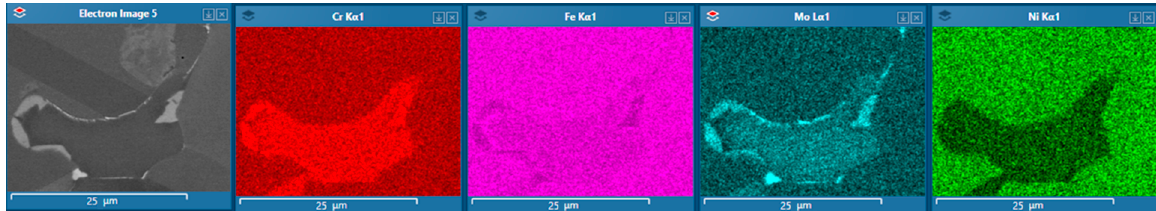
Figure 12. ThermoCalc prediction of equilibrium phases in SS316L as a function of temperature. BCC_A2 is the delta-ferrite phase. FCC_A1 is the austenite phase. A clear technical path to improve creep resistance includes powder and process op- timization studies towards achieving an optimal microstructure: 1.